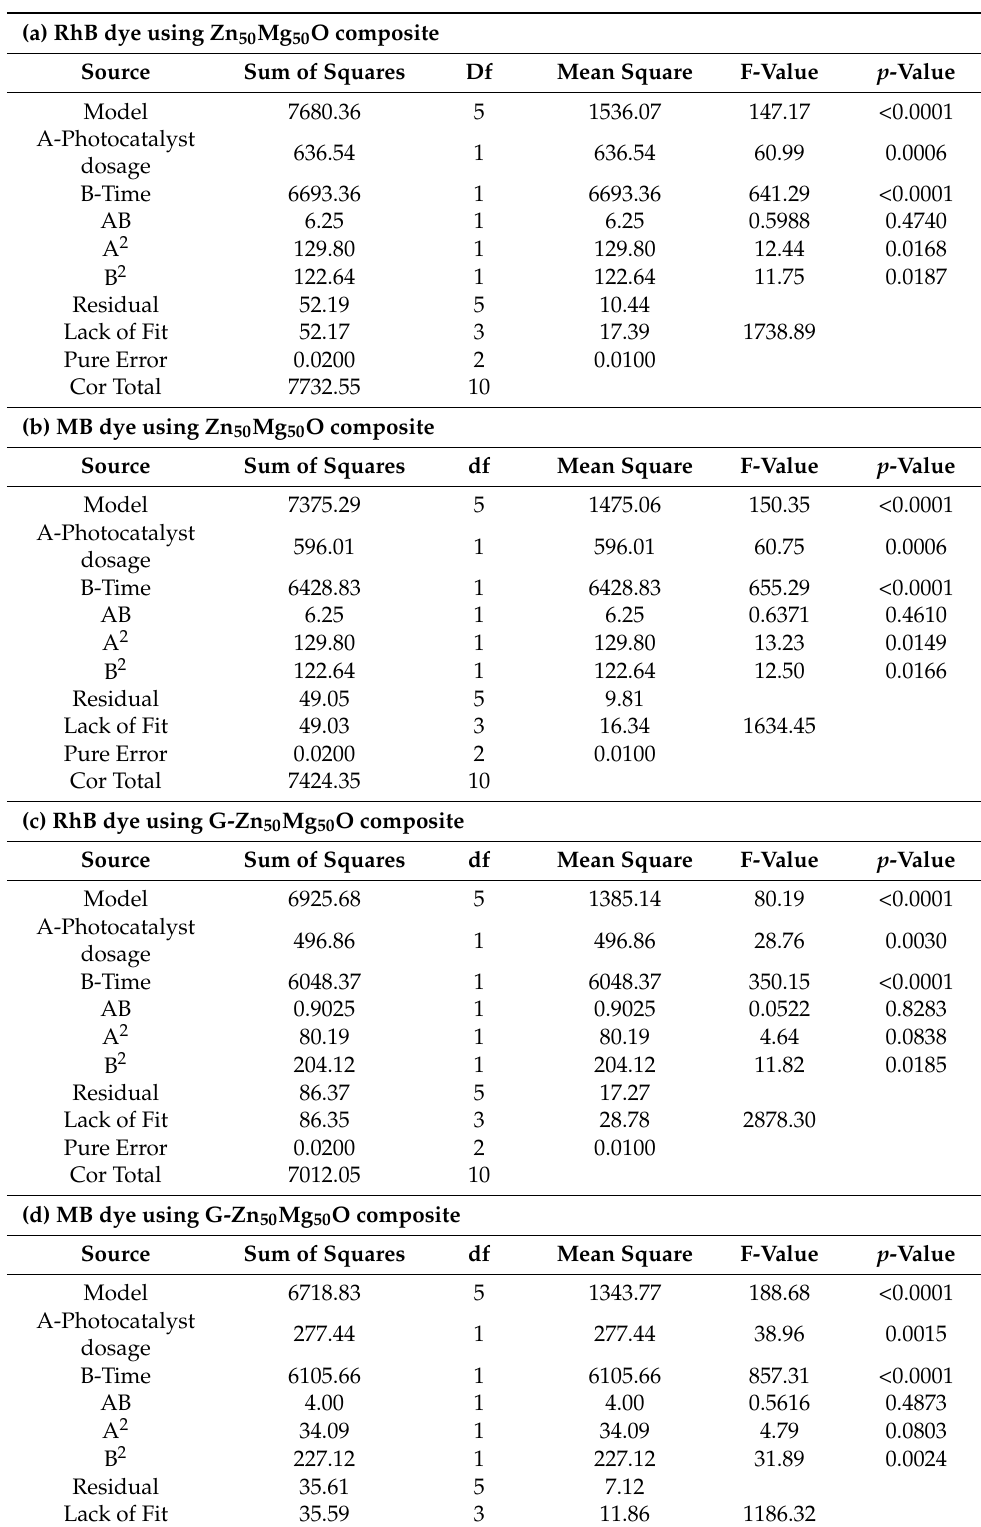
Table 3. Analysis of variance (ANOVA) for the quadratic model developed for photocatalytic dye